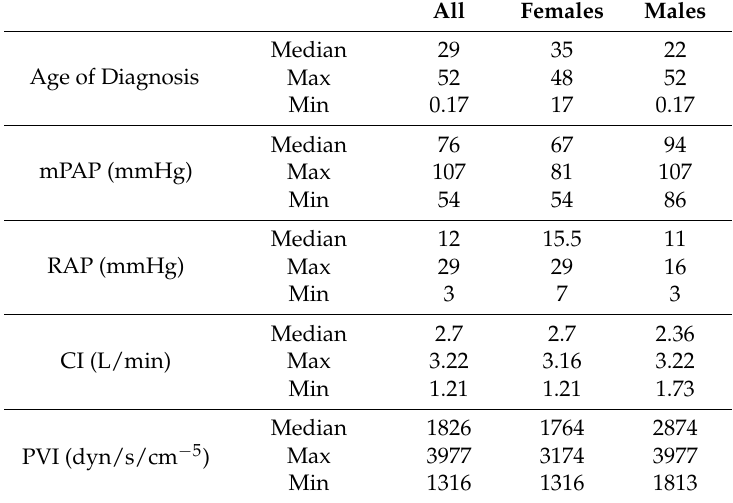
Table 3. Clinical measurements at diagnosis of KCNK3 mutation carrier PAH patients (Ma et al., 2013 [11]; Higasa et al. 2017 [15]; Navas tejedor et al., 2017 [13]; Best et al., 2017 [14]) mPAP, mean pulmonary arterial pressure; RAP, Right atrial pressure; CI, Cardiac index; PVI, pulmonary vascular resistance index. All Females Males Median 29 35 22 Age of Diagnosis Max 52 48 52 Min 0.17 17 0.17 Median 76 67 94 mPAP (mmHg) Max 107 81 107 Min 54 54 86 Median 12 15.5 11 RAP (mmHg) Max 29 29 16 Min 3 7 3 Median 2.7 2.7 2.36 Max 3.22 3.16 3.22 CI (L/min) Min 1.21 1.21 1.73 Median 1826 1764 2874 Max 3977 3174 3977 PVI (dyn/s/cm − 5 ) Min 1316 1316